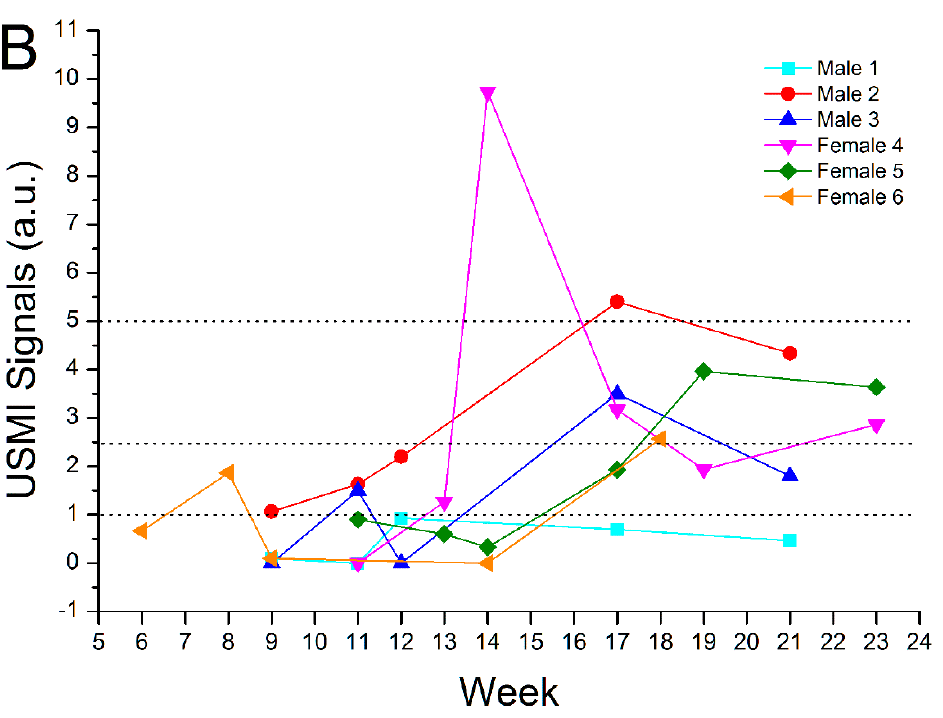
Figure 4. USMI signals fluctuated between 6–30 weeks of age in IL-2R α -/- mice. First, the USMI signals from three USMI imaging acquisitions of the proximal, middle, and distal colon in an IL-2R α -/- mouse in the same imaging session were averaged out as a single value of imaging signal per mouse per time point. Afterwards, all the single values from all the IL-2R α -/- mice imaged at multiple time points between 6–30 weeks were pooled together. ( A ) The mean USMI signals in IL-2R α -/- mice between 6–30 weeks were higher than wild-type mice, and fluctuated between the 2 consecutive time points. Black * indicates p value < 0.05 between the box of wild-type mice and the box of IL-2R α -/- mice; olive ** indicate p value < 0.05 between the two boxes under the bar. ( B ) The evolution of inflammation degree at multiple time points from the six representative IL-2R α -/- mice. Most of the UMSI signals were higher than 1.0 a.u., while some of them fell below 1.0 a.u. There was at least one peak of USMI signals in each mouse, suggesting the recapitulation of remission-flare pattern in patients with IBD. The frequencies and duration of remission-flare vary in each mouse.